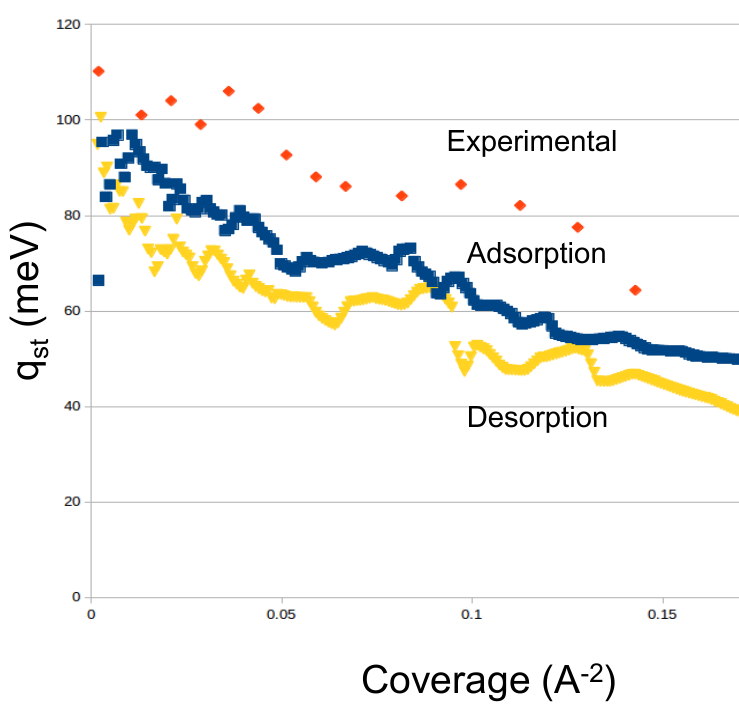
Figure 6. Isosteric heat of adsorption and desorption of argon. Also shown are the experimental data from